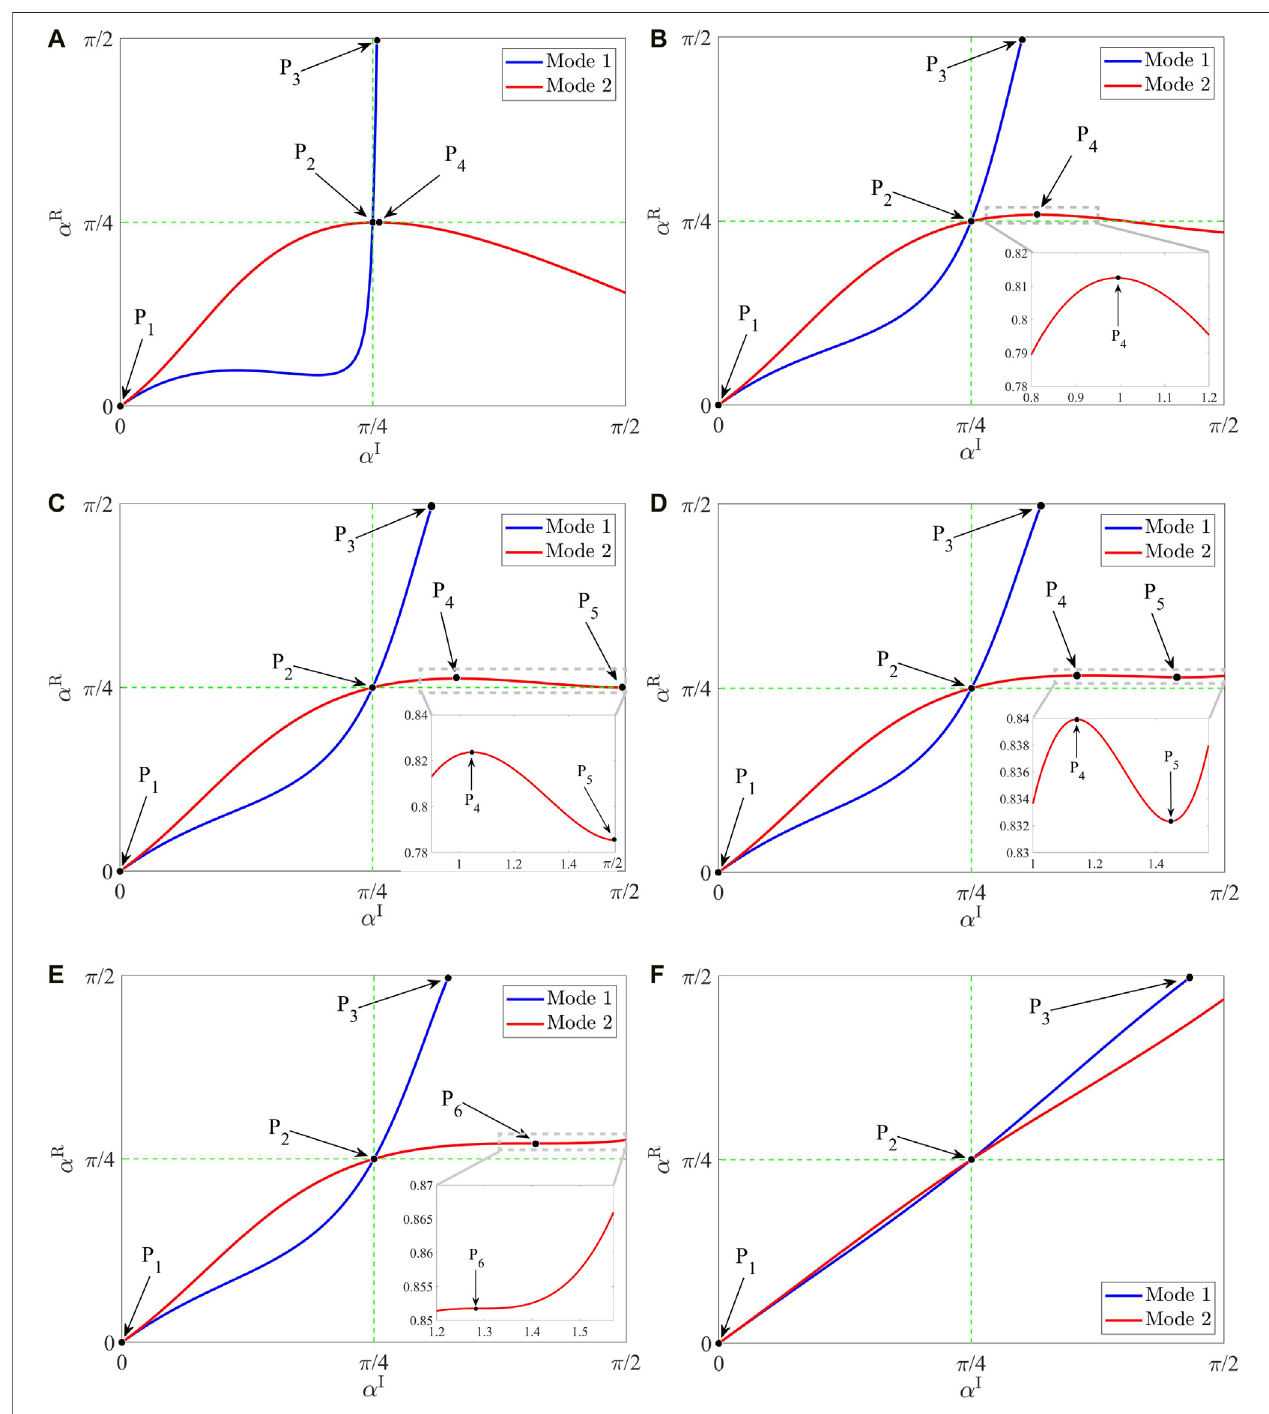
FIGURE7| There fl ectionangle α R oftwomodeswithrespecttotheincidenceangle α I . (A) C r (cid:2) 0.9, (B) C r (cid:2) 0.1, (C) C r (cid:2) 0, (D) C r (cid:2)− 0.1, (E) C r (cid:2)− 0.149452, (F) C r (cid:2) − 0.9.